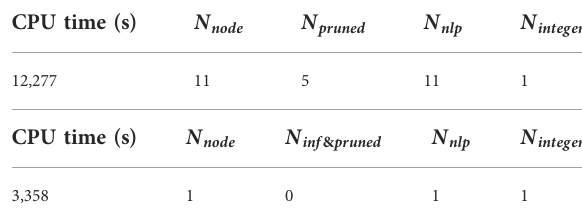
TABLE 9 Computational performance for Example